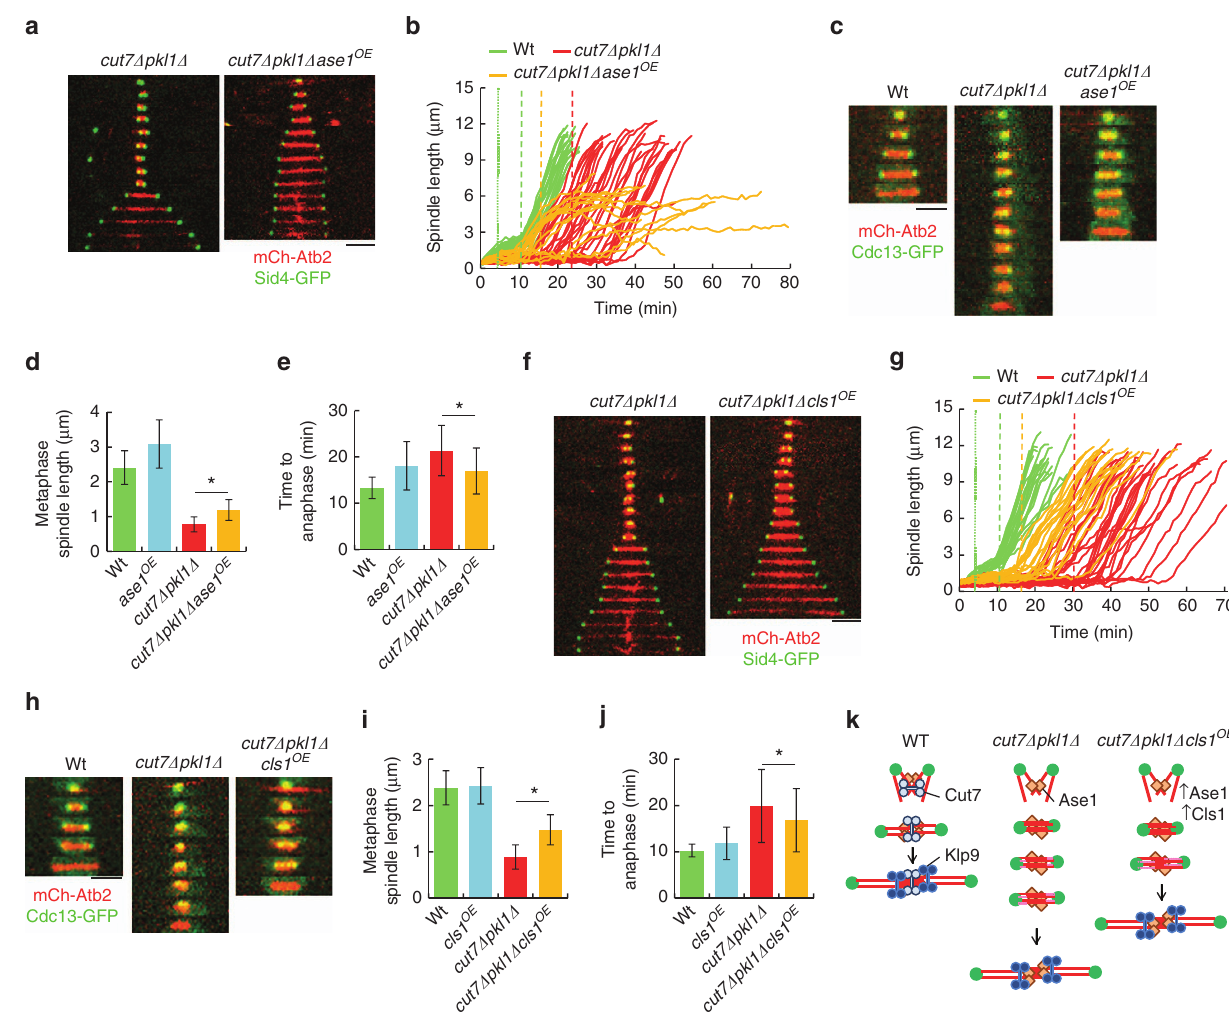
Figure 4 | Increased metaphase spindle length reduces anaphase transition time in cut7 D pkl1 D cells. ( a ) Time-lapse images of cut7 D pkl1 D and cut7 D pkl1 D ase1 OE cells expressing mCherry-Atb2 and Sid4-GFP from mitosis onset to spindle breakdown. Each frame corresponds to 3min interval. ( b ) Comparative plots of spindle length dynamics of cut7 D pkl1 D (red curves; n ¼ 33) and cut7 D pkl1 D ase1 OE cells (orange curves; n ¼ 15). Dotted vertical line corresponds to phase I–II transition; dashed vertical line corresponds to phase II–III transition. ( c ) Time-lapse images of wild-type, cut7 D pkl1 D and cut7 D pkl1 D ase1 OE cells expressing mCherry-Atb2 and Cdc13-GFP from mitosis onset to beginning of anaphase. Each frame corresponds to 3min interval. ( d ) Bar plot showing metaphase spindle length at anaphase transition, reported by Cdc13-GFP degradation, of wild-type (green; n ¼ 33), ase1 OE (light blue; n ¼ 28), cut7 D pkl1 D (red; n ¼ 25) and cut7 D pkl1 D ase1 OE (orange; n ¼ 30). * P o 0.001. ( e ) Bar plot showing anaphase transition time of wild-type (green; n ¼ 33), ase1 OE (light blue; n ¼ 28), cut7 D pkl1 D (red; n ¼ 25) and cut7 D pkl1 D ase1 OE (orange; n ¼ 30). * P o 0.01. ( f ) Time-lapse images of cut7 D pkl1 D and cut7 D pkl1 D cls1 OE cells expressing mCherry-Atb2 and Sid4-GFP from mitosis onset to spindle breakdown. Each frame corresponds to 3min interval. ( g ) Comparative plot of spindle length dynamics of cut7 D pkl1 D (red curves; n ¼ 31) and cut7 D pkl1 D cls1 OE cells (orange curves; n ¼ 19). Dotted vertical line corresponds to phase I–II transition; dashed vertical line corresponds to phase II–III transition. ( h ) Time-lapse images of wild-type, cut7 D pkl1 D and cut7 D pkl1 D cls1 OE cells expressing mCherry-Atb2 and Cdc13-GFP from mitosis onset to beginning of anaphase. Each frame corresponds to 3min interval. ( i ) Bar plot showing metaphase spindle length at anaphase transition, reported by Cdc13-GFP degradation, of wild-type (green; n ¼ 37), cls1 OE (light blue; n ¼ 23), cut7 D pkl1 D (red; n ¼ 88) and cut7 D pkl1 D cls1 OE (orange; n ¼ 97). * P o 0.001. ( j ) Bar plot showing the time from MT nucleation to Cdc13-GFP degradation of wild-type (green; n ¼ 37), cls1 OE (light blue; n ¼ 23), cut7 D pkl1 D (red; n ¼ 88) and cut7 D pkl1 D cls1 OE cells (orange; n ¼ 97). * P o 0.05. ( k ) Model for spindle assembly and transition to anaphase (see text for details). Data show mean ± s.d. and Student’s t -test P value. Scale bars, 2 m m.